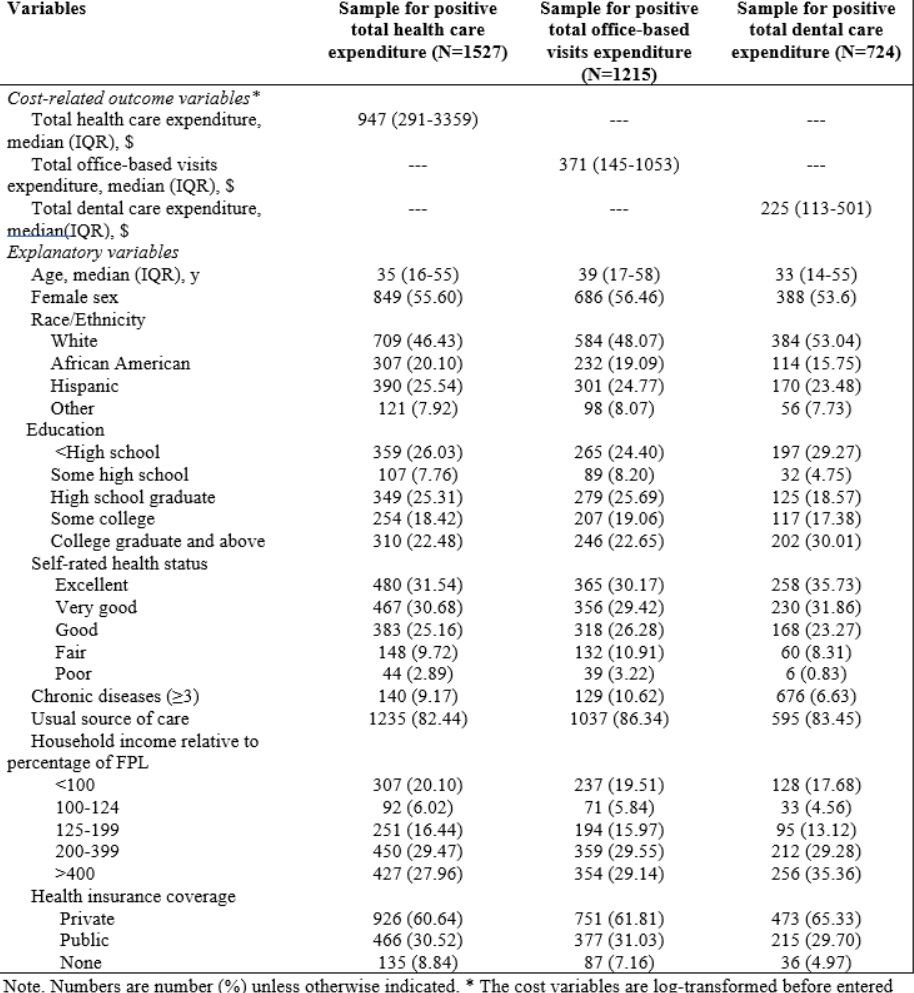
Table A3. Distribution of the cost-related outcome variables and patient